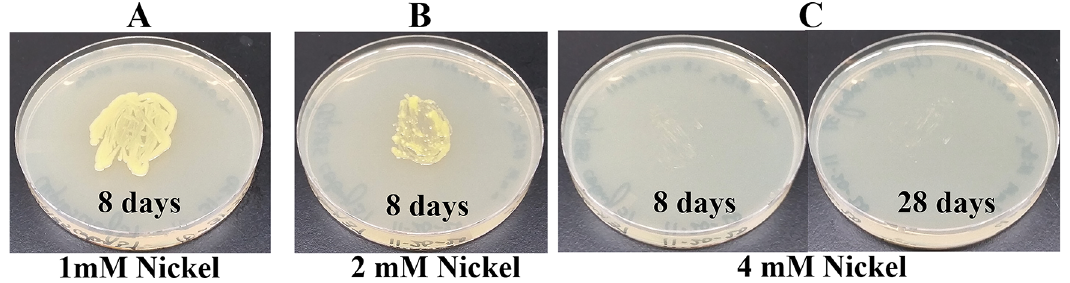
Figure 18. Growth of Clip185 on LB media containing Nickel. (A) 8 days-growth of Clip185 on LB media containing 1 mM Nickel. (B) 8 days-growth of Clip185 on LB media containing 2 mM Nickel. (C) 8 days (left) and 28 days (right)- growth of Clip185 on LB media containing 4 mM Nickel. Number of days of growth are labeled on the figures. Light intensity was 10-15 μ mol m -2 s -1 .